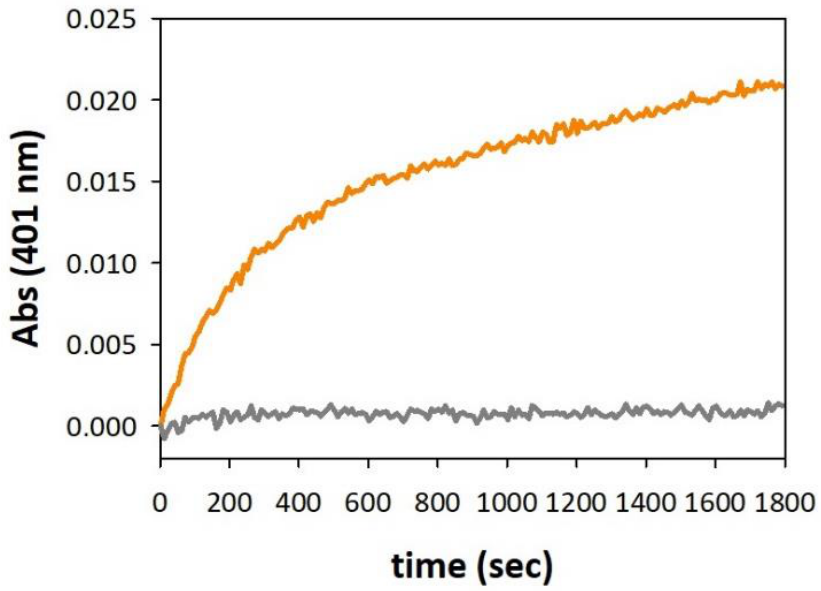
Figure 5. Kinetic profiles of 4-MC (3 mM) oxidation over time in 50 mM HEPES buffer at pH 7.4 and 20 °C containing SDS (20 mM) and in the presence of Cu + (25 μM) alone (orange trace) or Cu + (25 μM) and αSyn (50 μM) (grey trace). Copper(I) was generated in situ by anaerobic reaction of copper(II) nitrate (25 μM) and ascorbate (50 μM) prior to exposure of the solution to air.